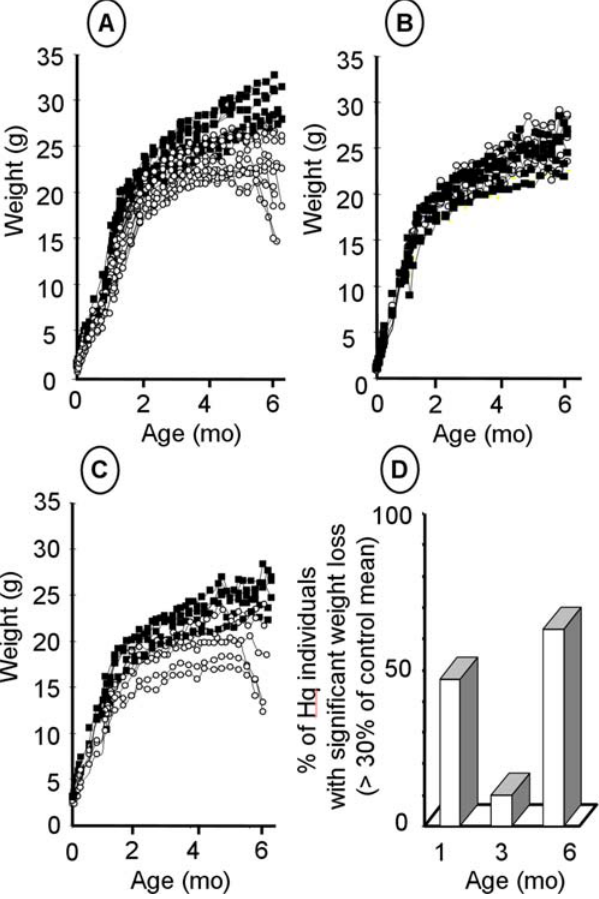
Figure 1. Time-course of weight loss in Harlequin mice. A: Weight changes with age in Harlequin hemizygous males ( Hq /Y; n=19) and wild-type males (B6CBACa Aw-J/A-Pdcd8 strain; n=14). B, C: Weight changes with age in wild-type (n=6) and heterozygous females ( Hq / Aif + ; n=6) (B) and in homozygous females ( Hq / Hq ; n=6) (C). D: Weight deficiency in Hq mice (n=25) compared to wild type mice (n=20) at various ages. Dark squares and open circles indicate control and Hq mice